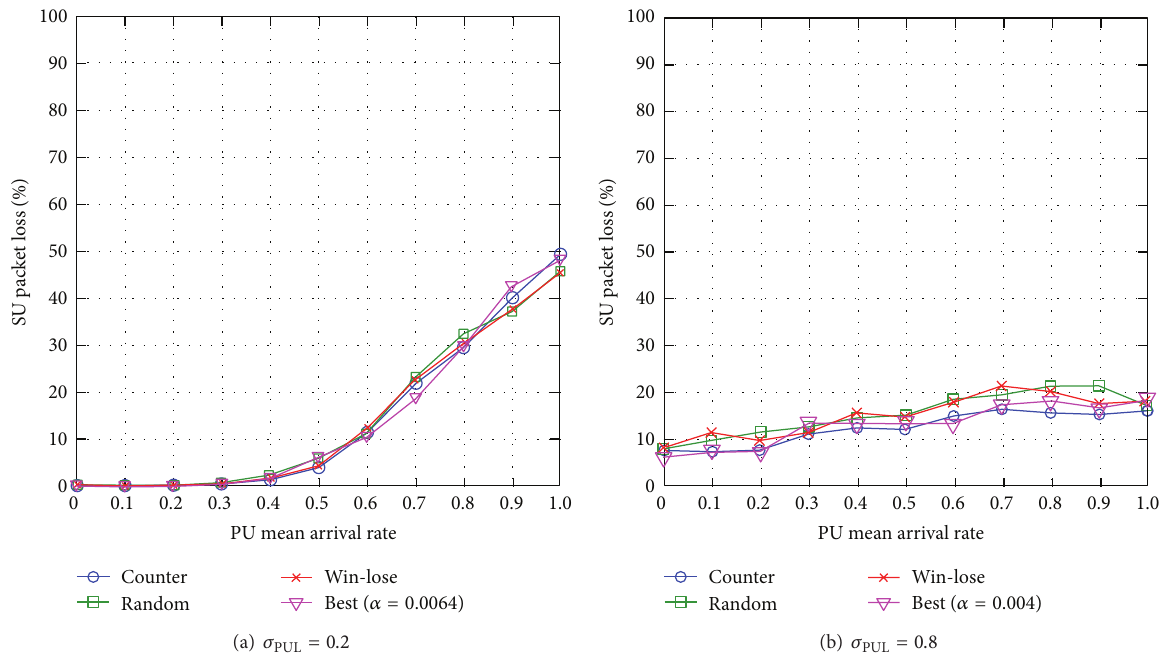
Figure 18: SU packet loss for varying PU mean arrival rate 𝜇